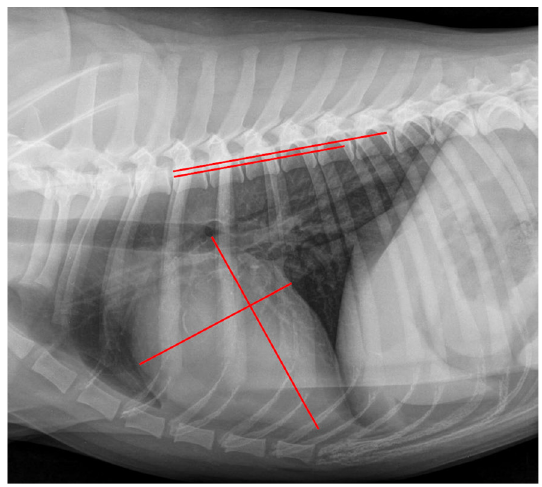
Figure 1. Measurement example of VHS. Right lateral thoracic radiograph displaying the Vertebral Heart Size (VHS) measurement in a dog of the control group. The long axis was drawn from the ventral margin of the carina tracheae to the most distal margin of the cardiac apex, and perpendicular to the short axis was drawn at the level of the ventral intersection of the caudal vena cava and the cardiac silhouette (red lines on cardiac silhouette). These lines were repositioned onto the vertebral column (red lines on vertebral column) beginning at the cranial margin of the fourth thoracic vertebrae. The VHS was 10.5 vertebral units.